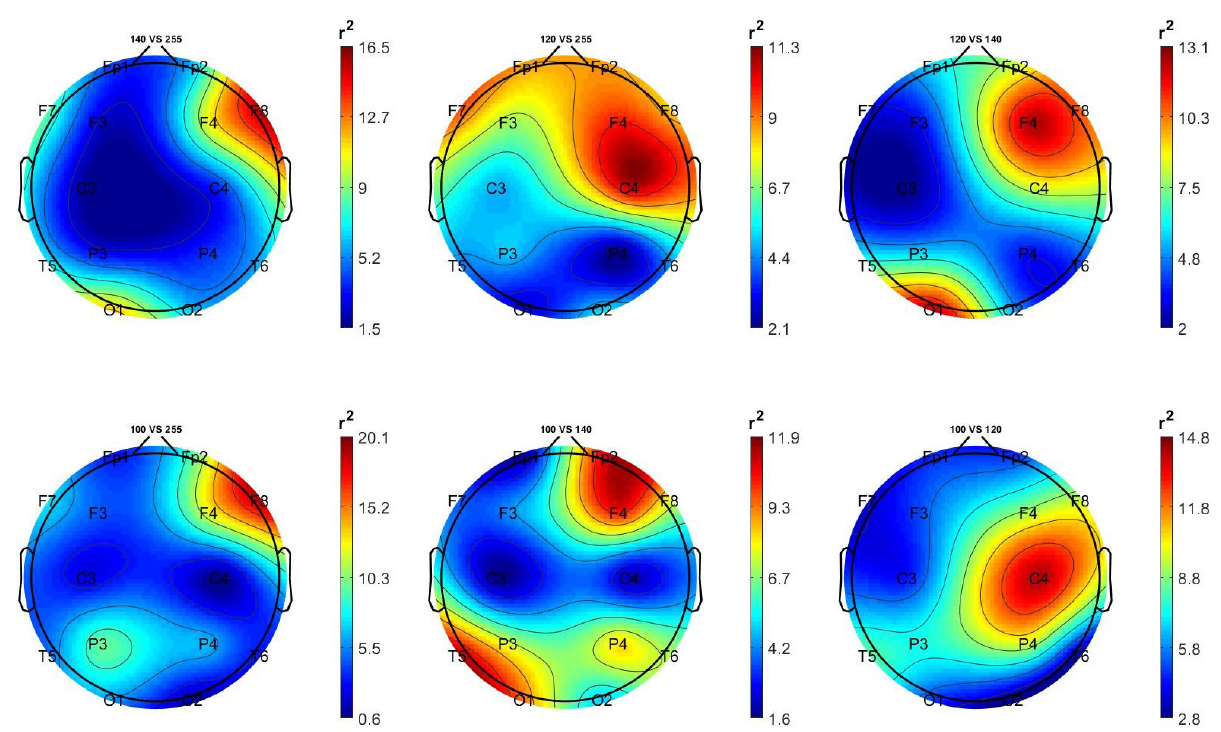
Figure 4. Topographic distribution of coefficients of r 2 (stimulation vs non-stimulation discriminative power) the non-stimulated participants. Top left: 14 Hz vs 0 Hz; top centre: 12 Hz vs 0 Hz; top right: 12 Hz vs 14 Hz; bottom left: 10 Hz vs 0 Hz; bottom centre: 10 Hz vs 14 Hz; bottom right; 10 Hz vs 12